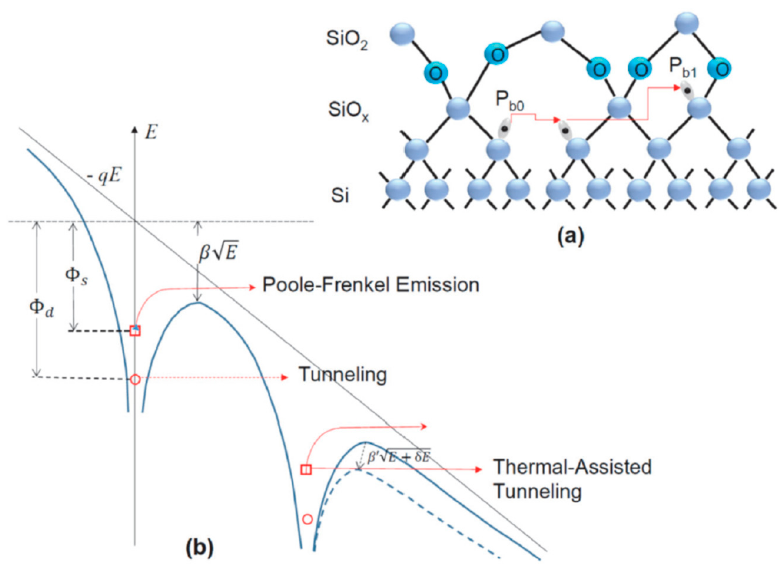
Figure 5. ( a ) Schematic showing the silicon dangling bonds (P b0 and P b1 ) at the Si(100) and SiO 2 interface and the possible charge transport through the neighboring interface states. ( b ) Illustration of the multiple Poole–Frenkel emissions through the interface states along the channel direction. Possible current enhancements due to a high local field, thermal-assisted tunneling, and direct tunneling are also shown.